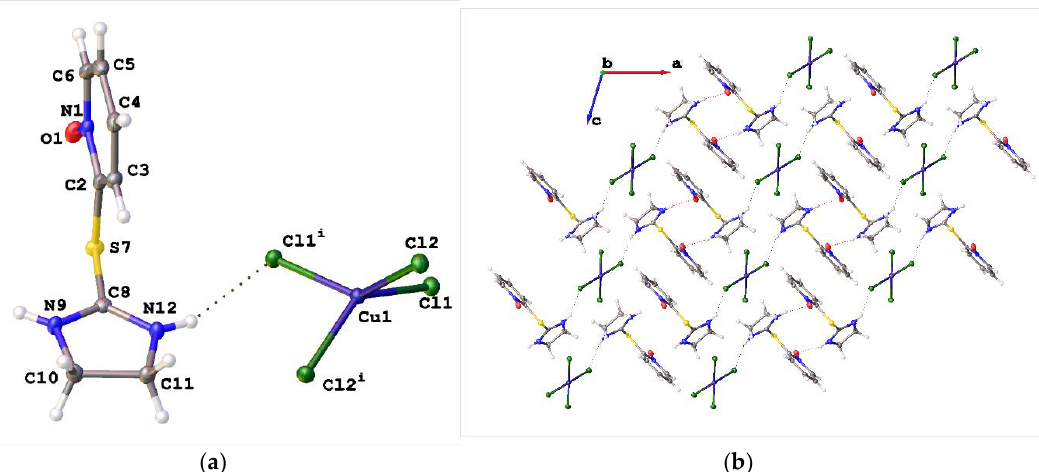
Figure 1. ( a ) ORTEP [18] representation of the molecular structure of 1a. Displacement ellipsoids are shown at the 50% probability level; ‘i’ relates to symmetry generated atoms. ( b ) Crystal packing viewed along the b axis with hydrogen bonds shown as dashed lines. Chains of hydrogen-bonded ionic species are extended along [1 0 1].